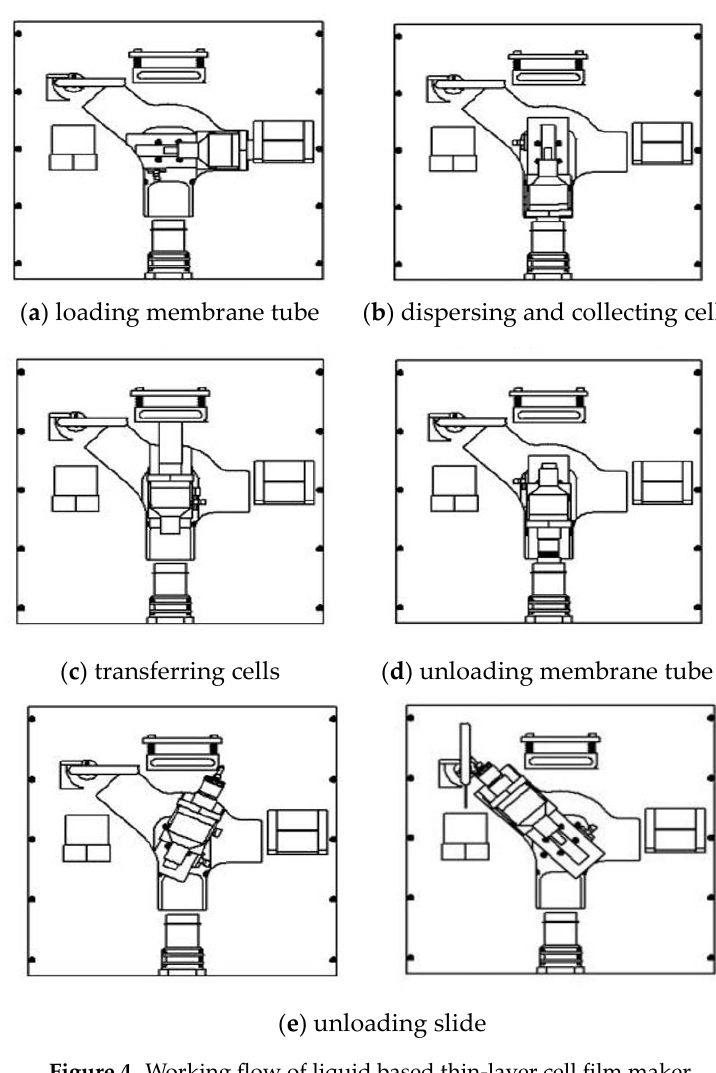
Figure 4. Working flow of liquid based thin-layer cell film maker.